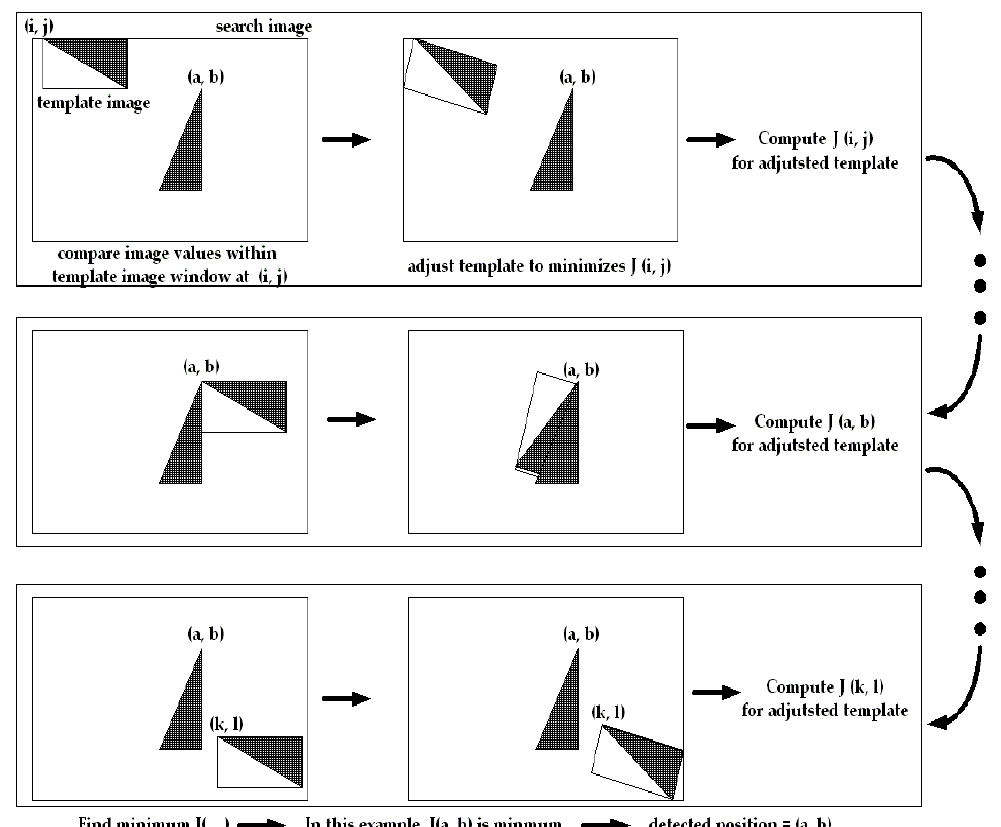
Figure 3. A test image of finding a right triangle with a different 90-degree angle from the template. Each step of Algorithm 1 was applied to the test image. The template window is moved to each pixel coordinate of the search image to analyze the image intensity distribution within the template window. (The first, second, and third lines describe the case of the template window at (i, j), (a, b), and (k, l), respectively.) Step 1 calculates the adjusted template parameters by analyzing the image intensity distribution of the template window at each position. As a result, we have the effect of rotating the template window at each position as shown in the middle figure of each row. Step 2 computes the matching measure value J for the rotated template at each position. Step 3 selects the minimum value among the matching measure values calculated at each position. In this test image, J (a, b) is minimal. Then the matching position will be (a,